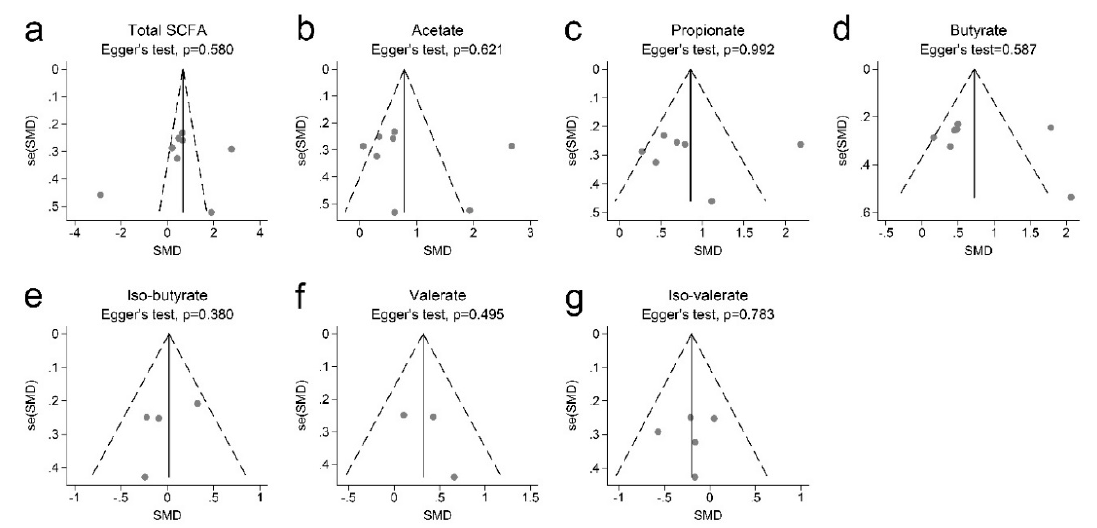
Figure 3. Begg’s funnel plots with 95% confidence intervals for the meta-analysis of SCFAs and obesity. ( a ) total SCFA; ( b) acetate; ( c ) propionate; ( d ) butyrate; ( e ) iso-butyrate; ( f ) valerate; ( g ) iso- valerate.